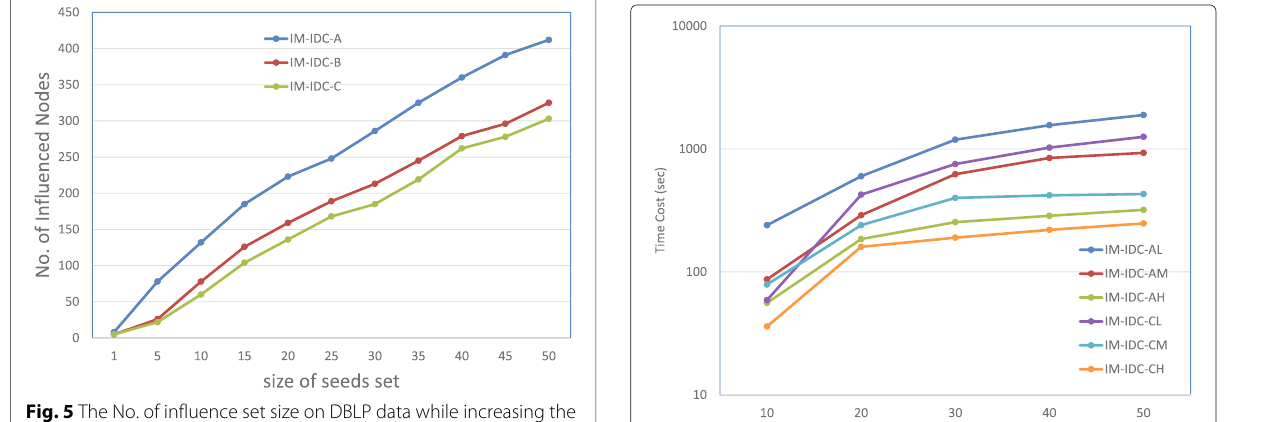
performances of A PPRO IM-IDC become much better.